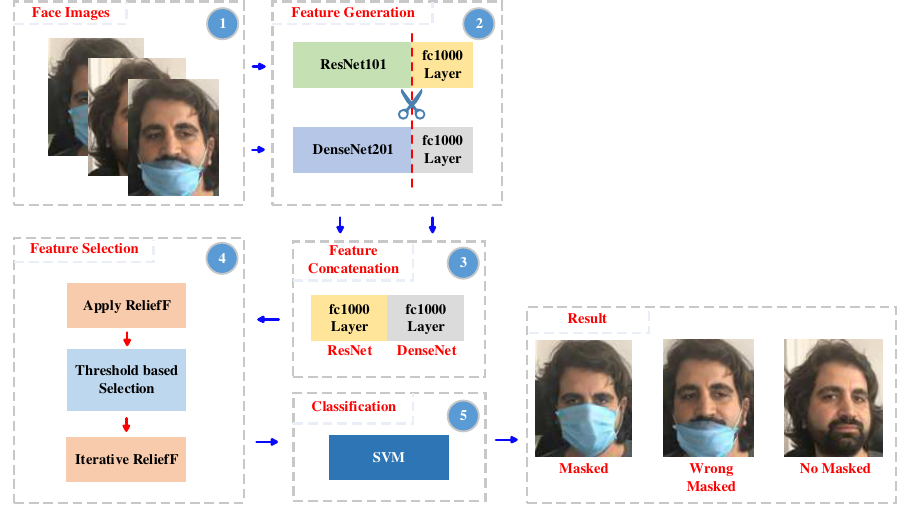
Figure 1. Illustration of the proposed hybrid deep features and TRFIRF-based face mask detection model.